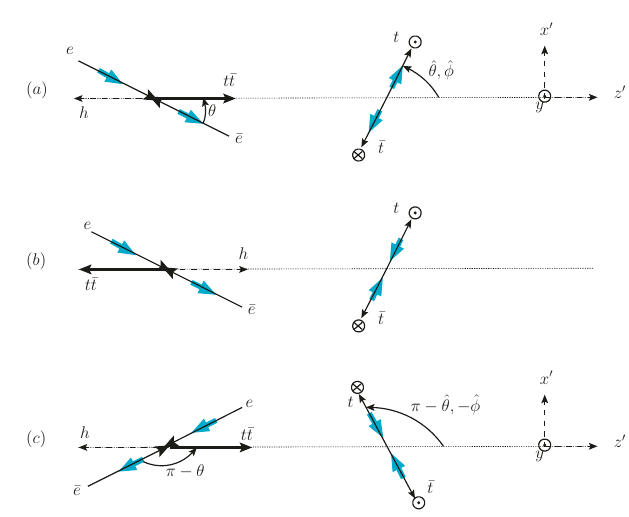
Figure 3 . CP transformation of e (cid:22) e ht (cid:22) t helicity amplitudes. Green shaded arrows show the ! spin direction along the particle momenta. The e and (cid:22) e momenta are shown in the e (cid:22) e rest frame, whereas t and (cid:22) t momenta are shown in the t (cid:22) t rest frame. The common z 0 -axis is chosen along the t (cid:22) t momentum in the e (cid:22) e rest frame, or the negative of the e (cid:22) e and the h momentum in the t (cid:22) t rest frame, and the common y -axis is vertical to the e (cid:22) e h + ( t (cid:22) t ) scattering plane; ~n y = ~p e (cid:2) ~p t (cid:22) t j ~p e (cid:2) ~p t (cid:22) t j ! in the e (cid:22) e rest frame. (a) shows the momenta and spins when the helicities of e; t and (cid:22) t are all + 1 , ( (cid:11) = (cid:27) = (cid:22) (cid:27) = +). The symbol ( ) shows that the y -component of each momentum is 2 (cid:12) (cid:10) positive (negative). Hence 0 < ^ (cid:18); ^ (cid:30) < (cid:25)= 2. (b) shows the process with CP transformed particles and their vectors in the original frames. (c) is obtained from (b) by two rotations, rotations of (cid:25) about the z 0 -axis and by the y -axis. The coordinate system parameterizing the three momentum is the same as in (a), and we can read o(cid:11) the CP transformation of the helicity amplitudes as given by eq.